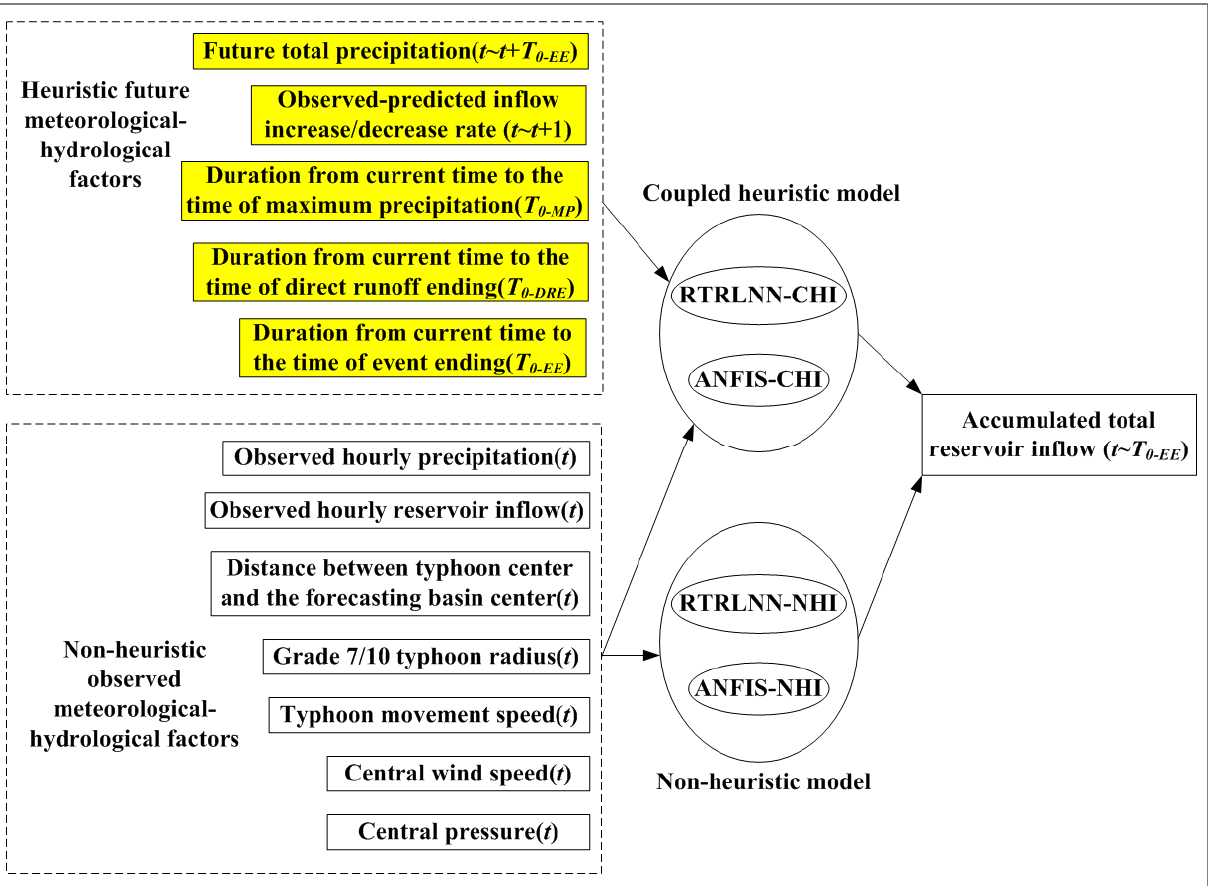
Figure 4. Structure of the developed coupled heuristic and non-heuristic accumulated total inflow forecast